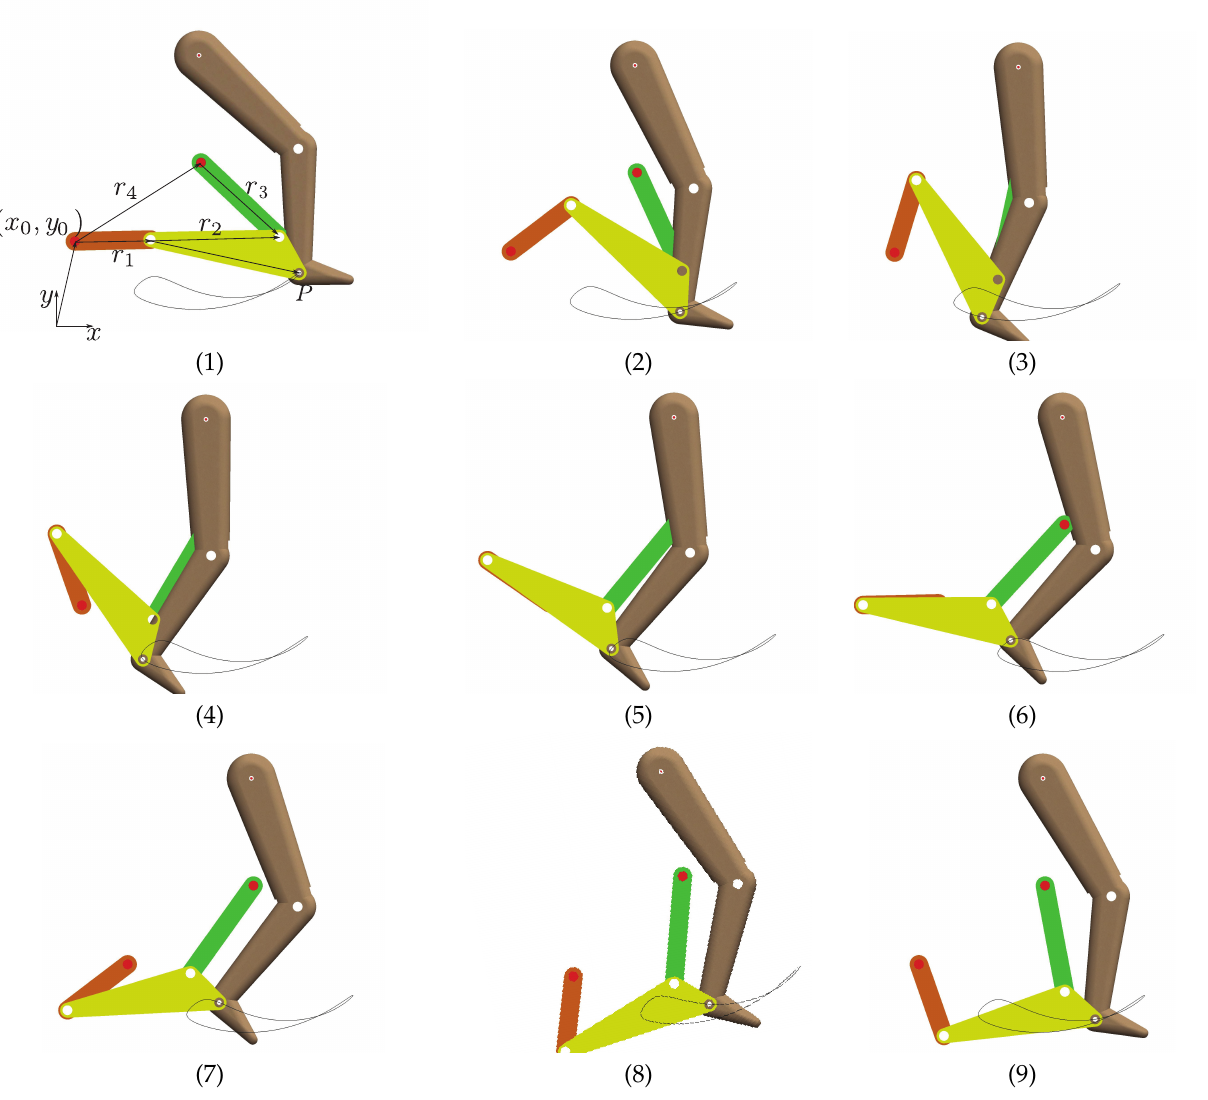
Figure 9. CAD representation of the best mechanism movement obtained by R1B-NCH for study case